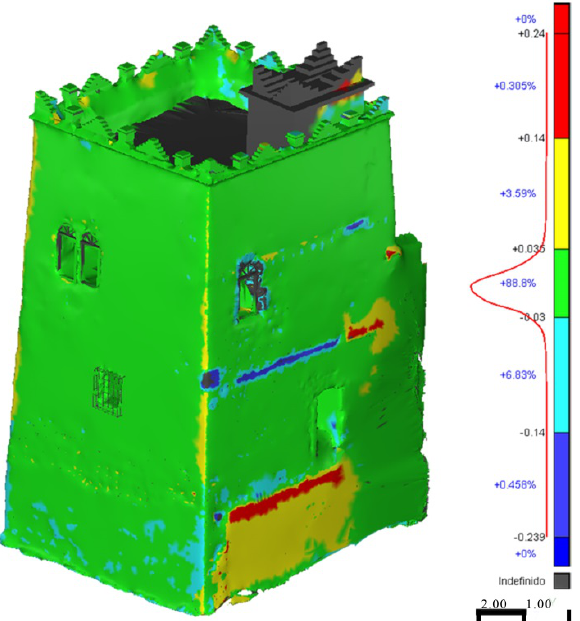
Figure 10. Differences between the current state of the Tower and the ideal state of the North and East